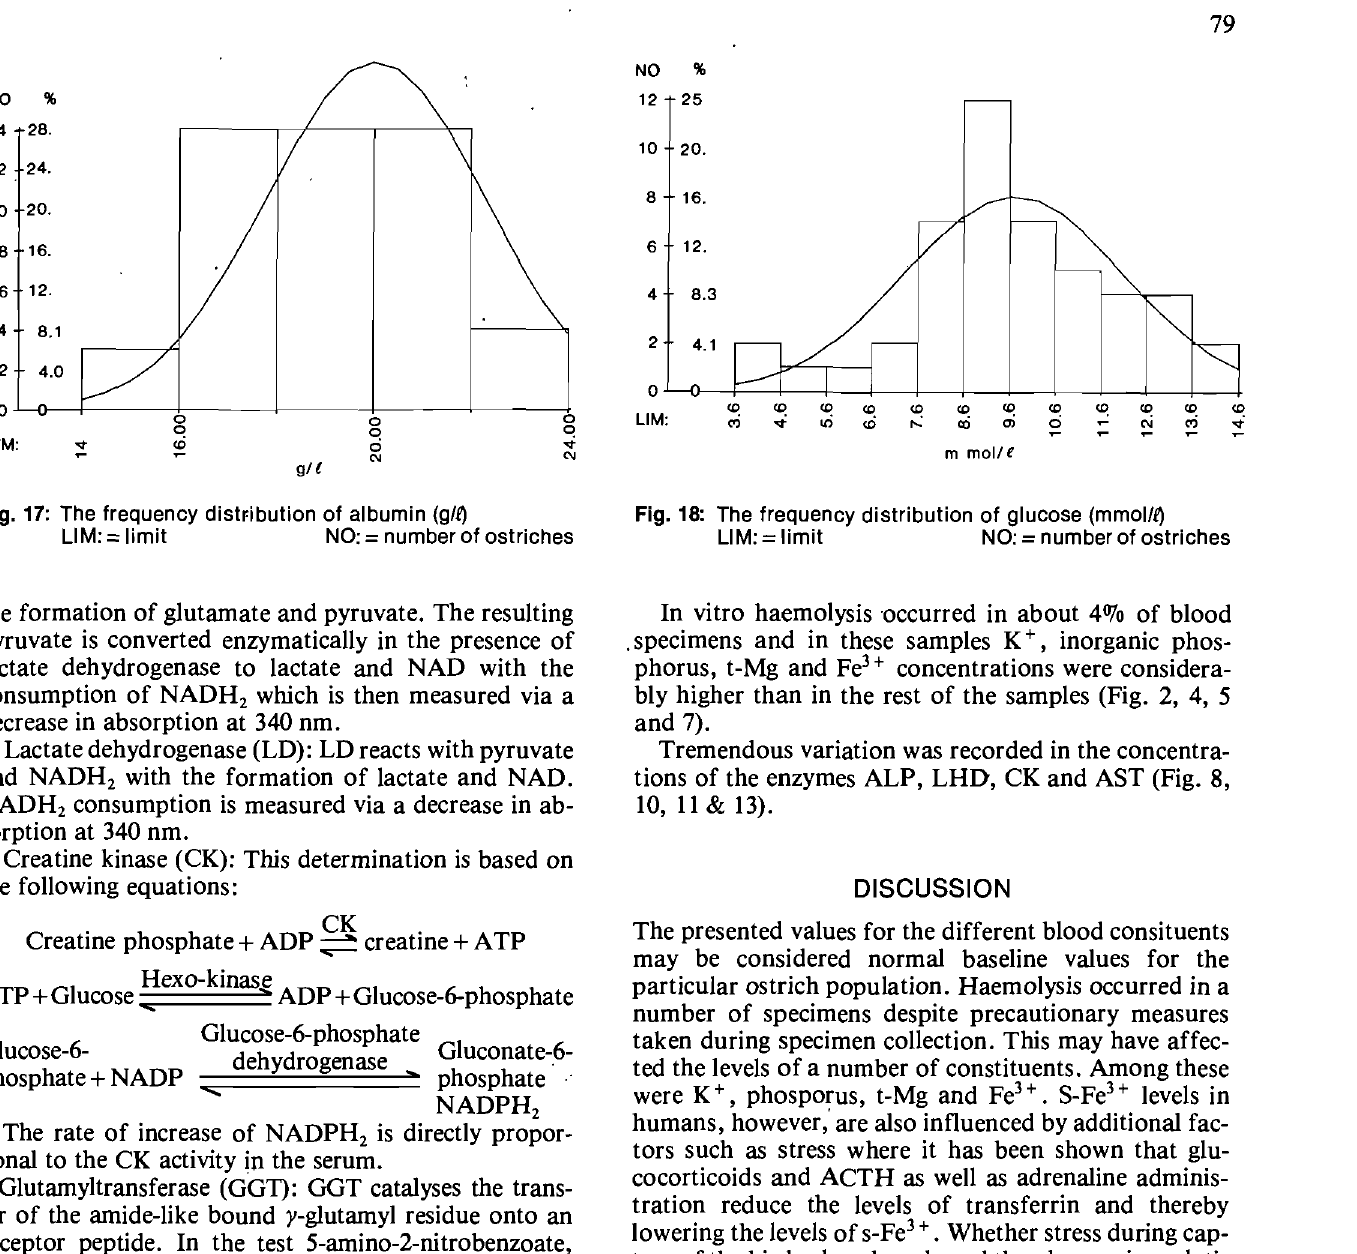
'" Fig. 18: The frequency distribution of glucose (mmolft) LIM: == limit NO: == number of